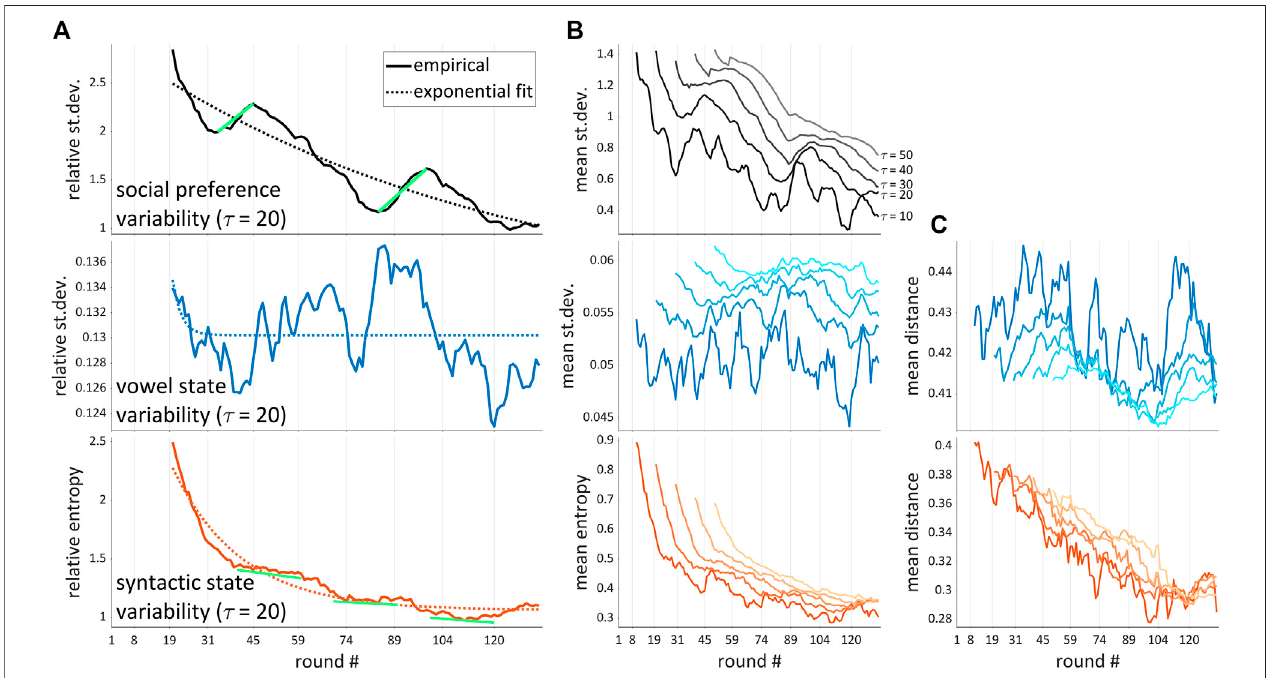
FIGURE 8 | Temporal evolution of system states. (A) : average measures of variability of social preference states (rankings), vowel states, and syntactic states calculated over 20 round windows; values are expressed relative to mean distances and are plotted at the end of the window. Green lines indicate potentially important departures from exponential decay. (B) time evolution of average variability measures calculated on a range of timescales. (C) time evolution of mean